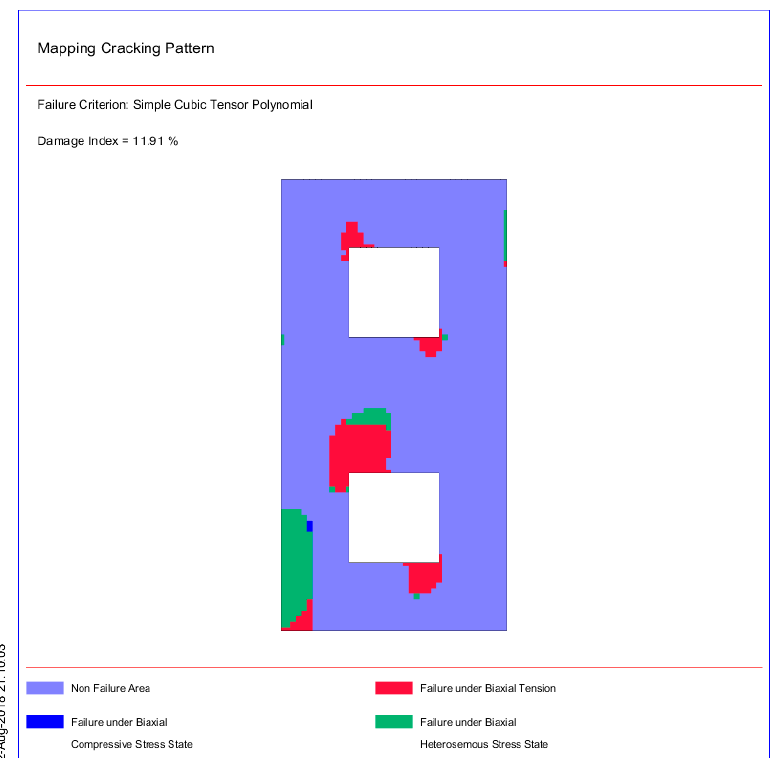
Figure 28. Mapping cracking pattern based on simple cubic tensor polynomial failure criterion.